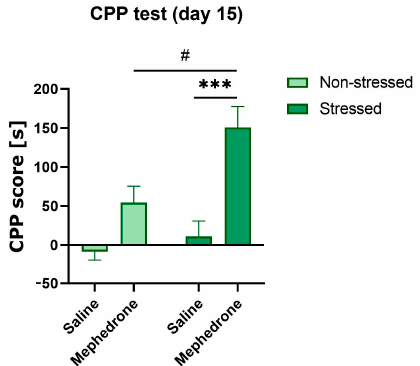
Figure 2. Impact of fear conditioning (PTSD ‐ like symptoms) on the acquisition of mephedrone (5 mg/kg)—induced CPP in adolescent rats. Data are expressed as scores (the differences between post ‐ test and test time spent in the drug ‐ associated compartment). Data represent mean SEM ( N = 7 rats/group). # p < 0.05 Stressed/Mephedrone vs. Stressed/Saline; *** p < 0.001 Stressed/Mephedrone vs. Non ‐ stressed/Mephedrone. 2.2. Stage 2: Impact of Repeated Mephedrone Injections on Fear Sensitization in Adolescent Rats. Anxiety ‐ Like Behavior Based on an Elevated Plus ‐ Maze Test Two ‐ way ANOVA of the freezing time of the animals in context B (day 16, 0.4 mA footshock) revealed the statistically significant influence of the stress factor [F (1,24) = 141.4, p < 0.001]. Two ‐ way ANOVA, however, did not show the significant effect of mephedrone administration [F (1,24) = 1.577, p > 0.05], nor interaction between these factors F (1,24) = 0.5563, p > 0.05]. The Bonferroni post ‐ hoc test showed statistically sig ‐ nificant differences in the freezing time between the stressed animals that received mephedrone in the CPP procedure and non ‐ stressed animals that also received mephedrone ( p < 0.001). Furthermore, significant differences were found between stressed animals receiving saline in the CPP procedure and control animals that received saline, but were not stressed ( p < 0.001). Differences between mephedrone ‐ treated and saline ‐ treated stressed animals were not significant (Figure 3A). Two ‐ way ANOVA of the freezing time of the animals in the context of A (day 17, no footshock) showed the statistically significant effect of the stress [F (1,24) = 19.72, p < 0.001] and the mephedrone factor [F (1,24) = 7.100, p < 0.05]. Two ‐ way ANOVA, however, did not show statistically significant interaction between these factors F (1,24) = 3.721, p > 0.05]. The Bonferroni’s multiple comparisons test showed statistically significant differences in the freezing time between stressed animals that received mephedrone in the CPP procedure and stressed animals that received saline ( p < 0.01). Significant differences were also observed be ‐ tween stressed animals that received saline and rats that received vehicle but were not previously stressed ( p < 0.001) (Figure 3B).